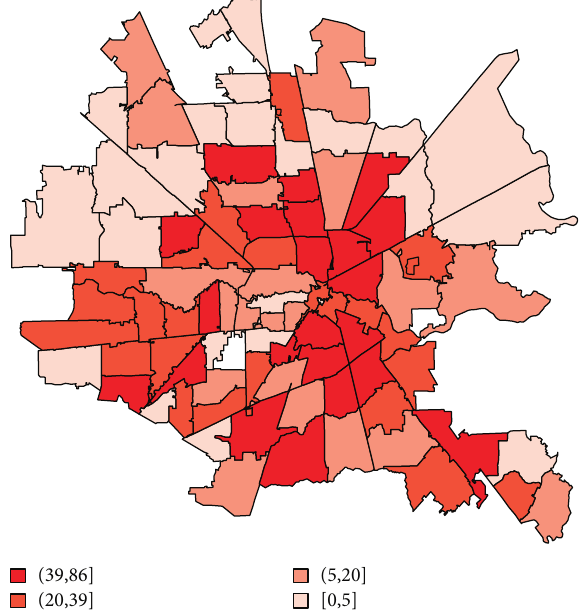
Figure 1: Cardiac arrest mortality by the Houston metro zip code ( N �